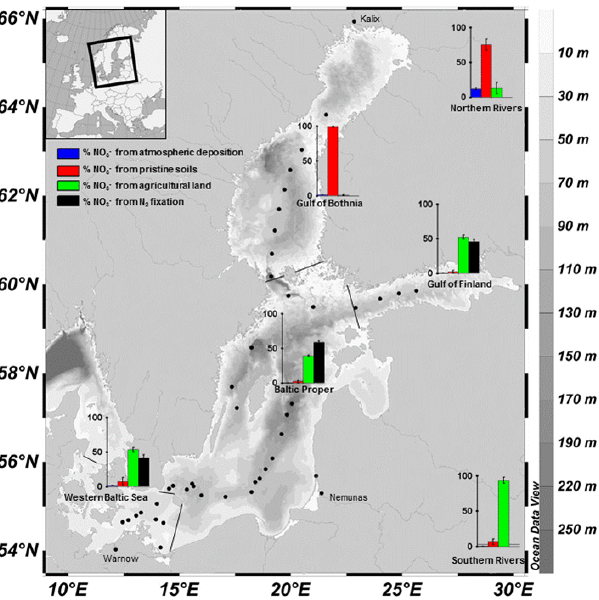
Figure 1. Station Map of the Baltic Sea and percent contribution of the four nitrate sources, NO − from atmospheric deposition (blue), 3 pristine soils (red), agricultural runoff (green), and N 2 fixation (black), for the Western Baltic Sea, Baltic Proper, Gulf of Finland, Gulf of Bothnia, southern rivers, and northern rivers. Stations are indicated as black dots. For more details see Supplement Table 1.